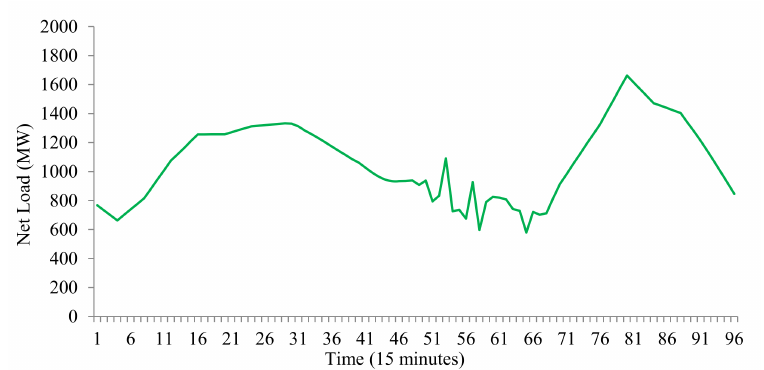
Figure 19. The net load curve of the IEEE 39 system.